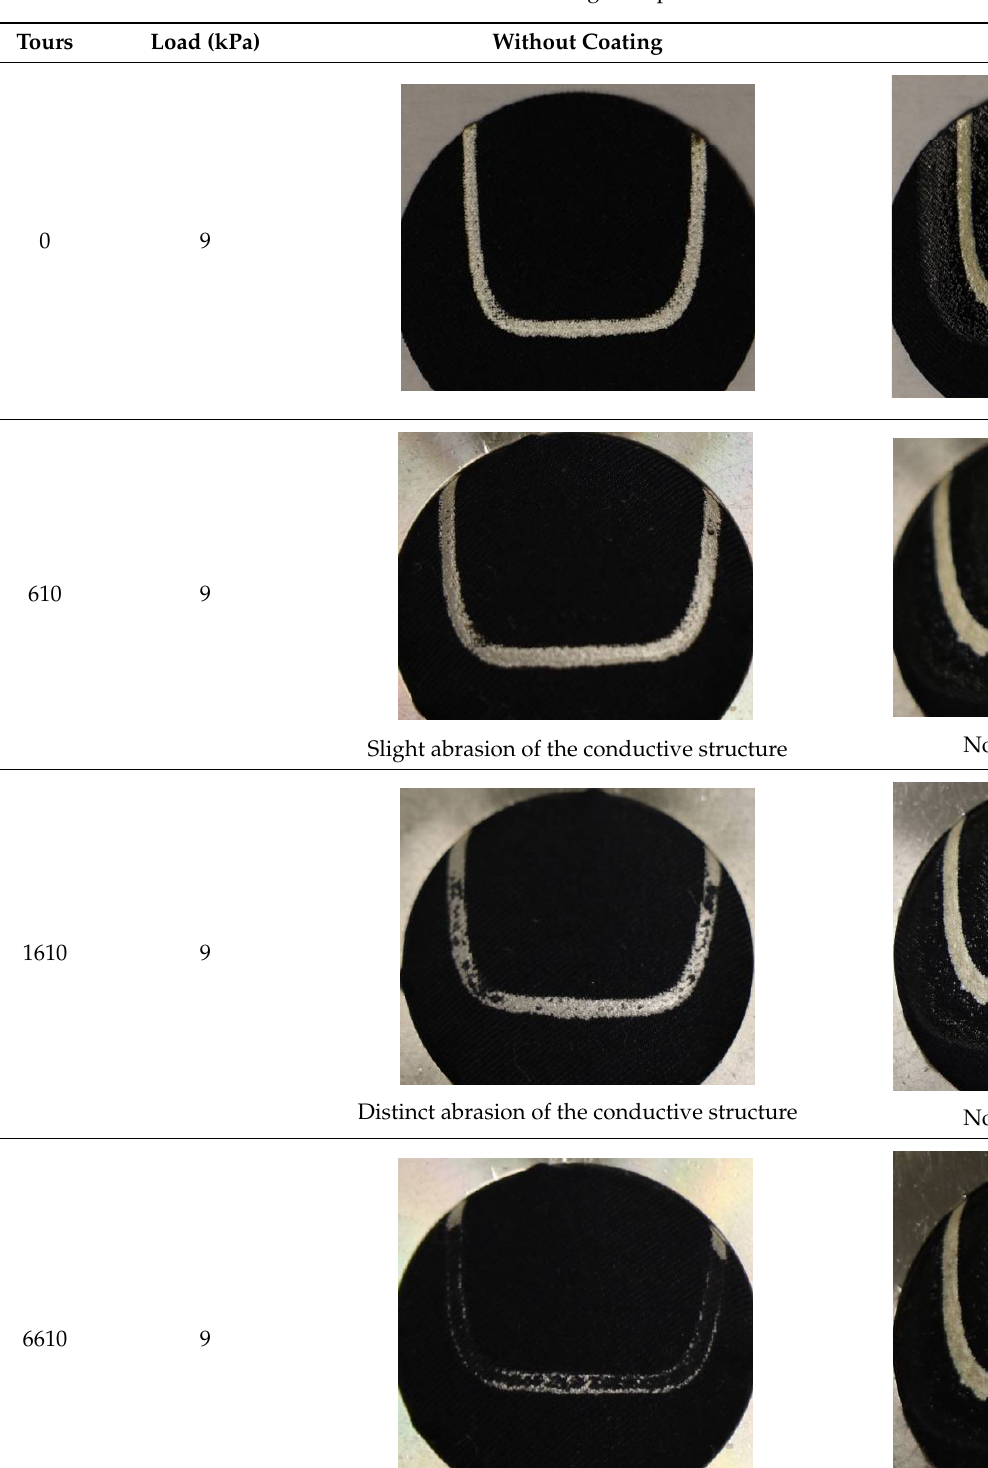
Figure 10. SEM images of samples single-layer coated ( a ) and double-layer coated ( b ).